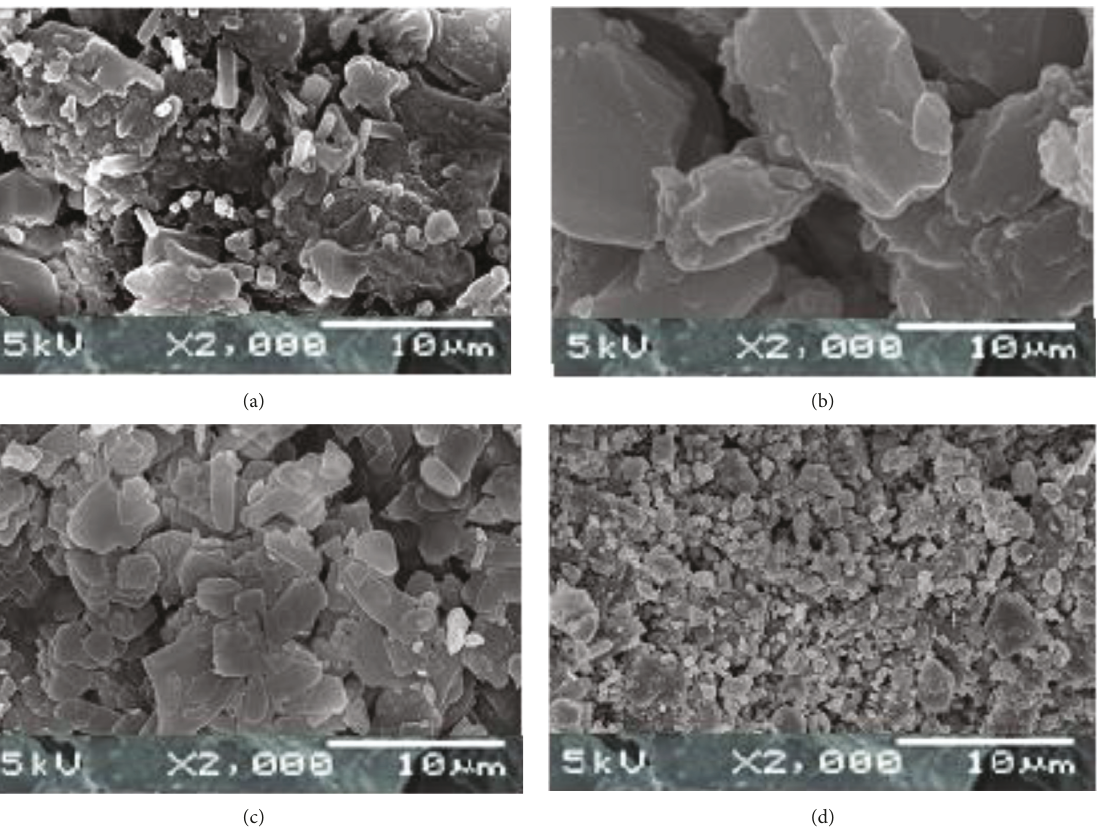
Figure 2: SEM micrograph of (a) LP, (b) MP, (c) WMP, and (d)